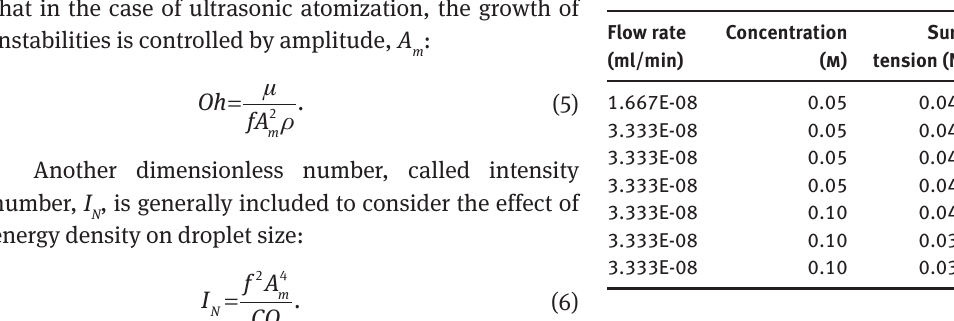
Table 3: Properties of the zinc nitrate aqueous